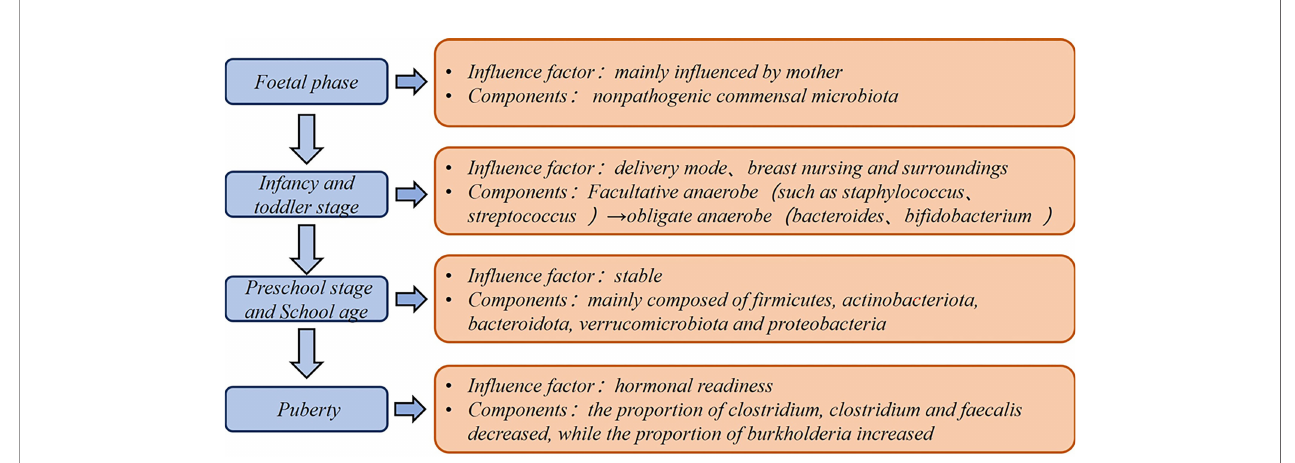
FIGURE 1 | Dynamics of intestinal fl ora in